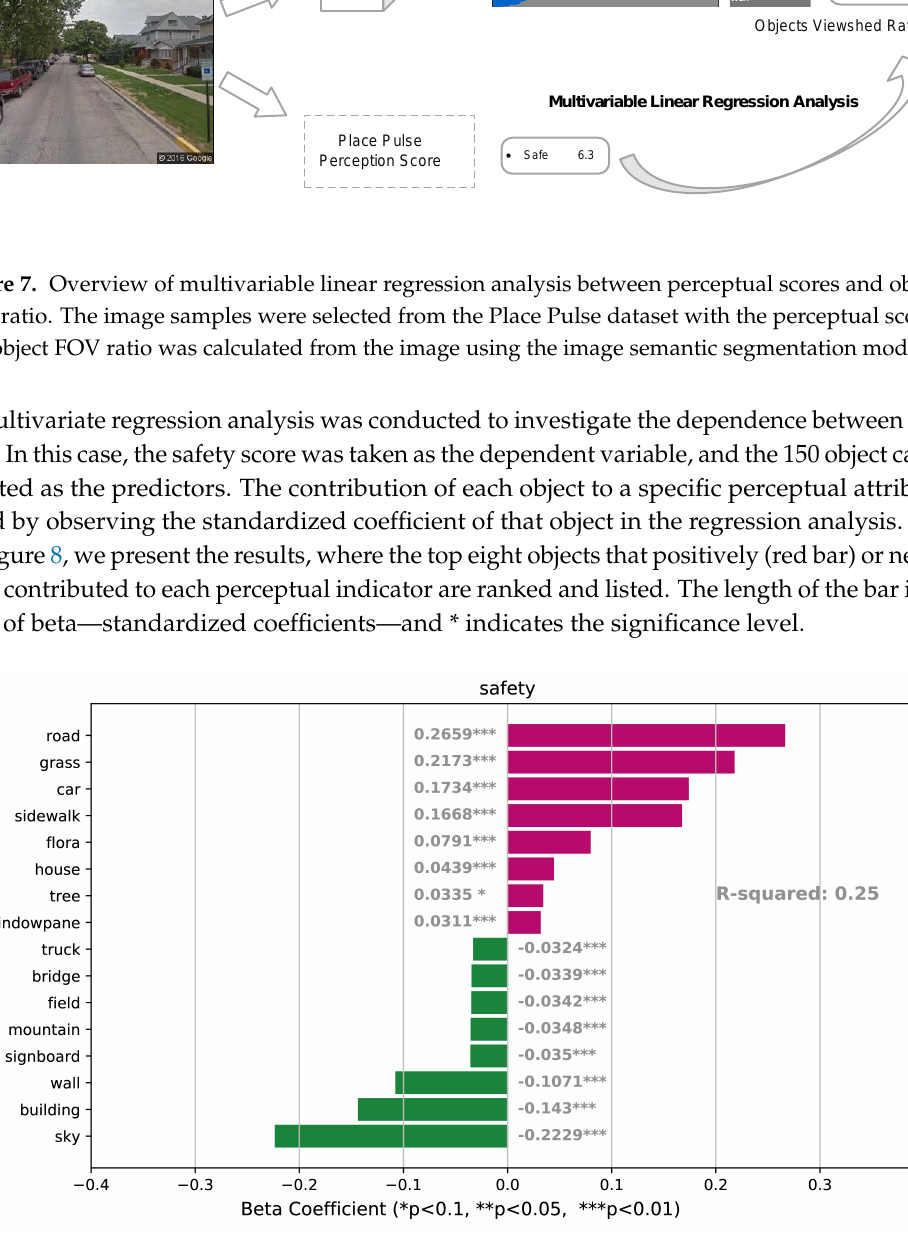
Figure 8. Results of multivariable regression analysis between scene elements and perception scores. For each pair, the pixel number of a particular object category and perception score along a specific dimension are given. The top eight objects that positively/negatively contributed to each of the six perception types are